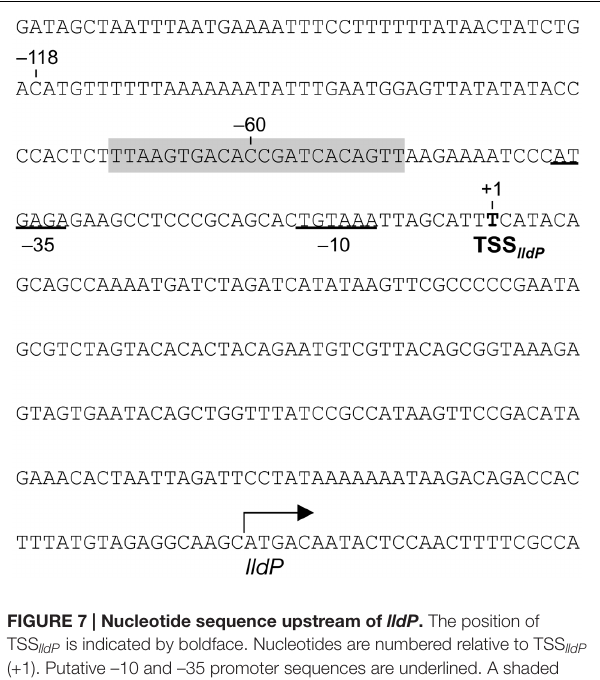
FIGURE 7 | Nucleotide sequence upstream of lldP . The position of TSS lldP is indicated by boldface. Nucleotides are numbered relative to TSS lldP (+1). Putative –10 and –35 promoter sequences are underlined. A shaded sequence indicates a putative CRP-binding motif.